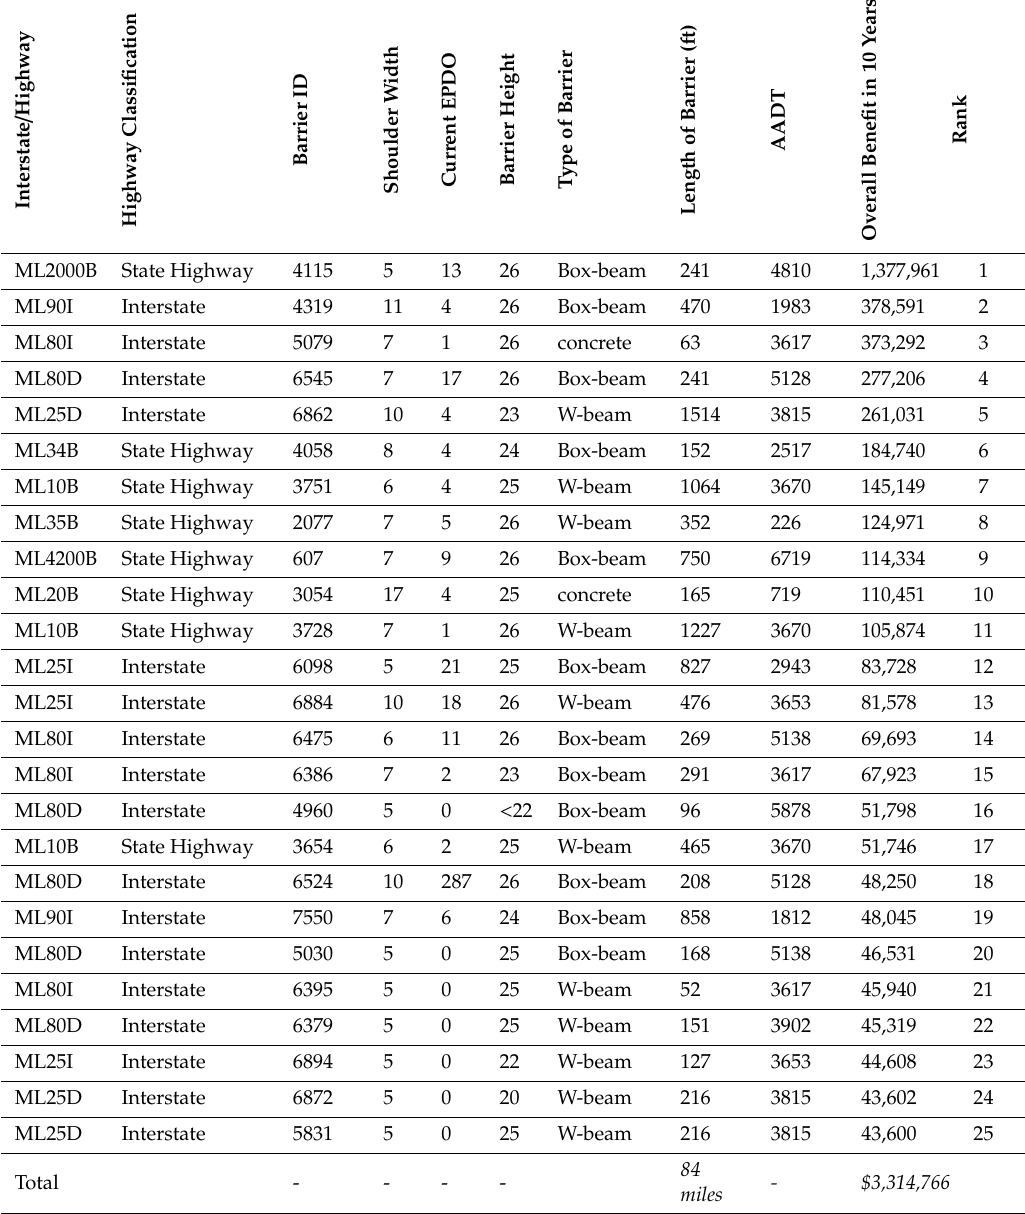
Table 6. The top critical highway-system barriers, sorted based on highest